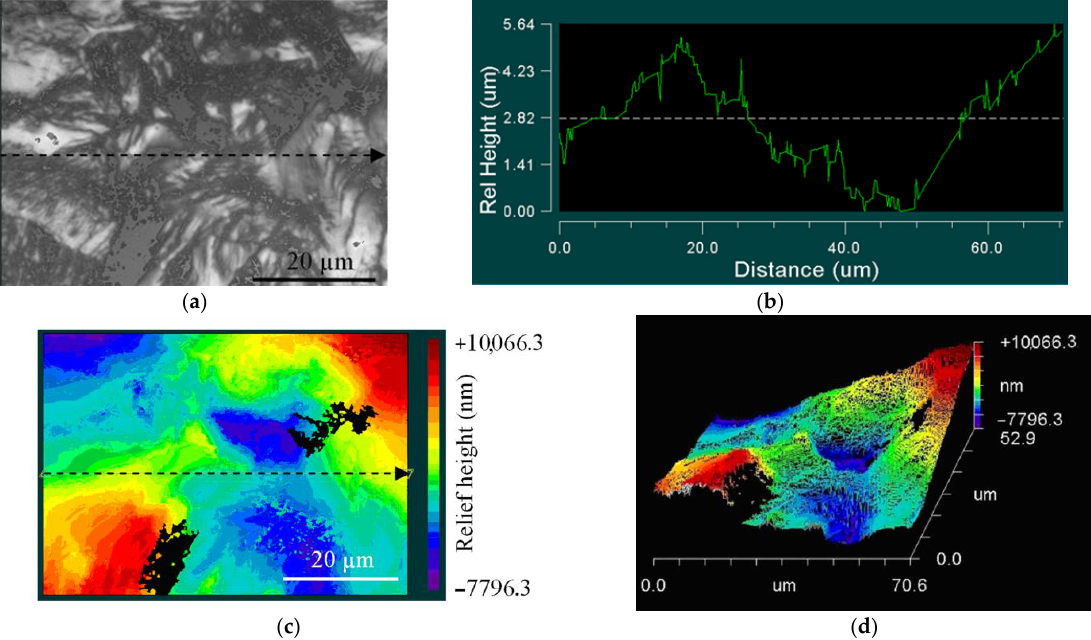
Figure 14. Images of damage to the surface, close to the crack initiation zone (zone 1) of the CG Ti − 45Nb alloy: ( a ) optical image of scanning area; ( b ) surface profile; ( c ) 2D-relief map; ( d ) 3D-relief map.